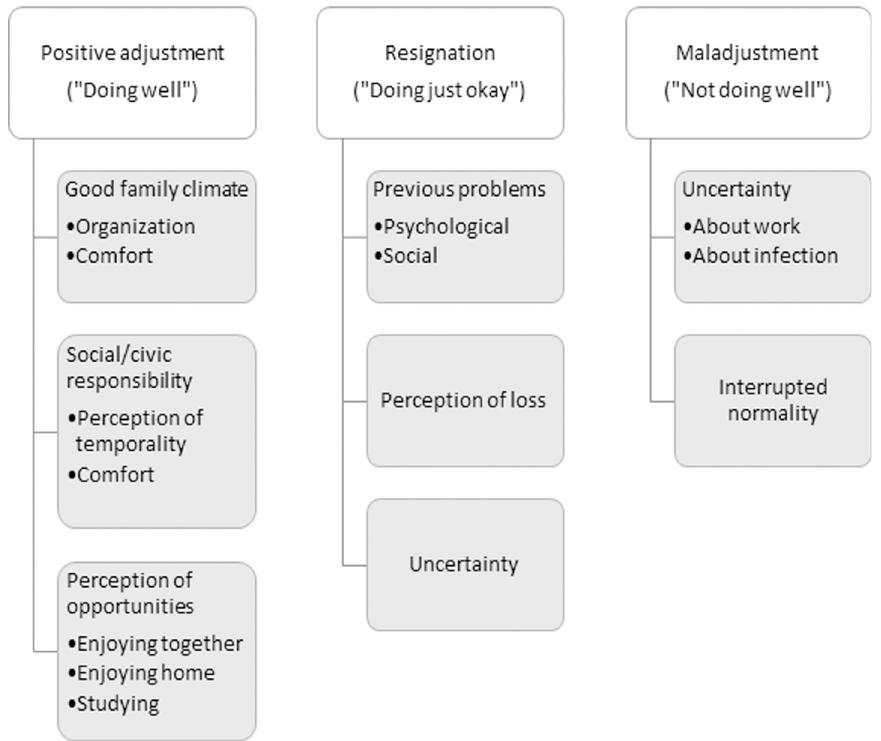
Fig 1. Core themes of parent’s discourse according to their perceived adaptation to